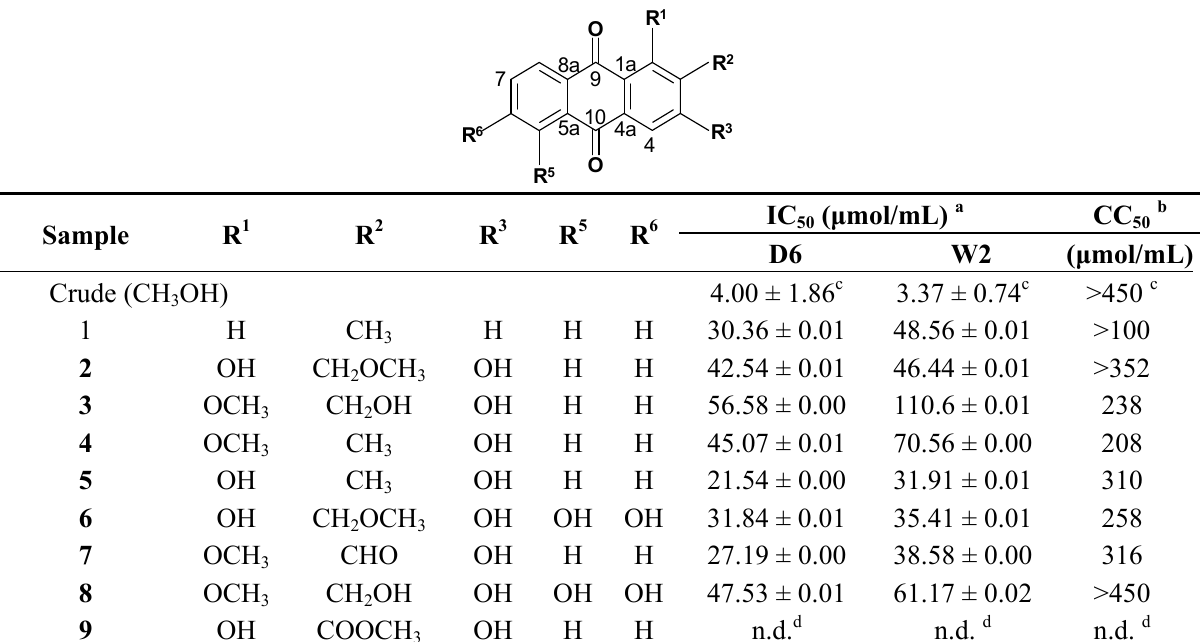
Table 2. Biological activities of the methanol root extract of P. micrantha and of the isolated constituents 1 – 9